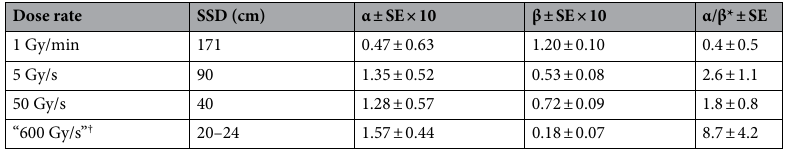
Table 2. Values of the coefficients α and β in the equation Y = αD + βD 2 and α/β quotients which gives the dose–response curves for each dose rate. *α/β quotient is the dose at which contributions from single-track (α coefficient) and double-track (β coefficient) events are equal. † 600 Gy/s is a rough approximation of the average dose rate. Dose was delivered as either two 1.5 Gy pulses or three 2.7 Gy pulses at a pulse duration of 130 ns and repetition rate of 180